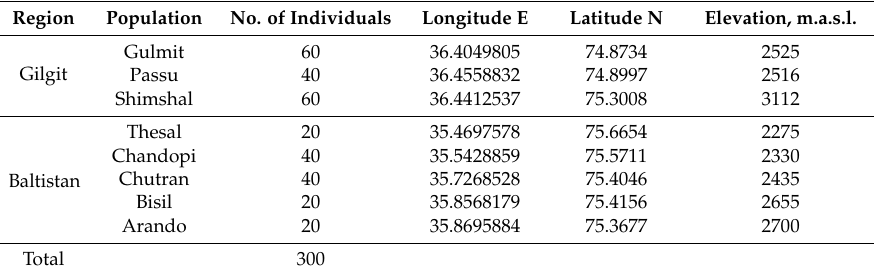
Table 1. Average geographic coordinates of the eight sea buckthorn populations studied in the Gilgit and Baltistan regions, Pakistan.